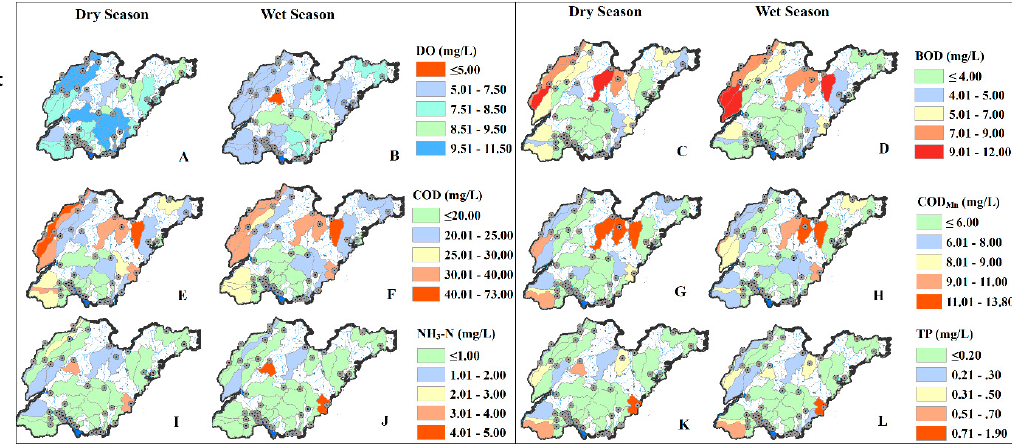
Figure 5. Spatial variations in water quality current status at 45 control units in wet and dry season from 2015 to 2017 ( A : the variation of DO in Dry Season; B : the variation of DO in Wet Season; C : the variation of BOD in Dry Season; D : the variation of BOD in Wet Season; E : the variation of COD in Dry Season; F : the variation of COD in Wet Season; G : the variation of COD Mn in Dry Season; H : the variation of COD Mn in Wet Season; I : the variation of NH 3 -N in Dry Season; J : the variation of NH 3 -N in Wet Season; K : the variation of TP in Dry Season; L : the variation of TP in Wet Season). Table 3. National quality standards for surface waters in China (GB3838-2002).